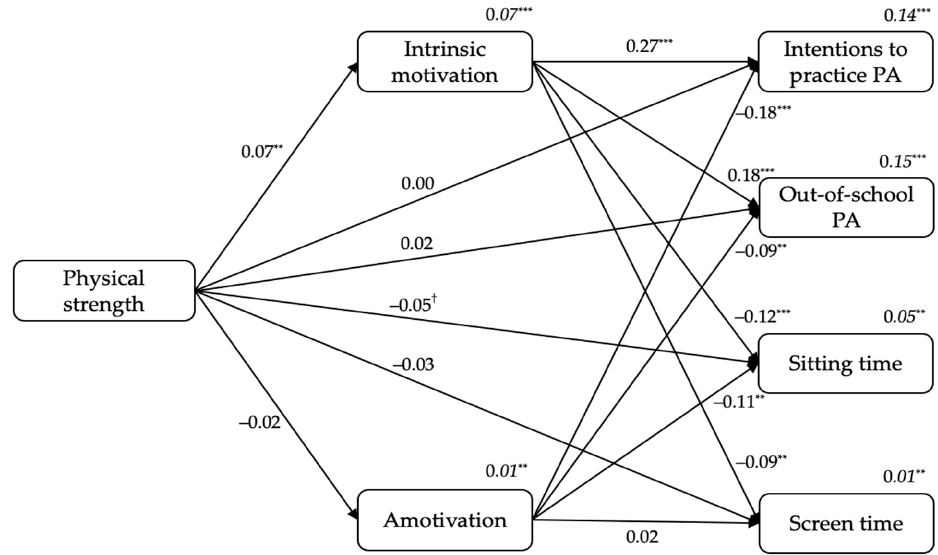
Figure 4. The standardized coefficients from students’ physical strength to intrinsic motivation and amotivation, and to outcomes. Note . † p < 0.05. ** p < 0.01. *** p < 0.001.